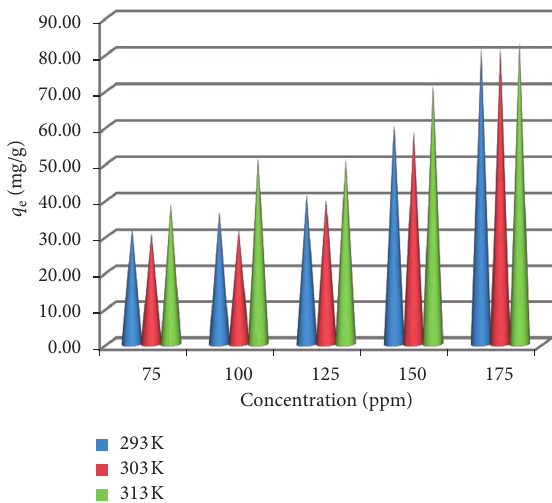
Figure 4: Effect of initial concentration and operating temperature on the adsorption of Cd(II) ions onto G-3 PAMAM